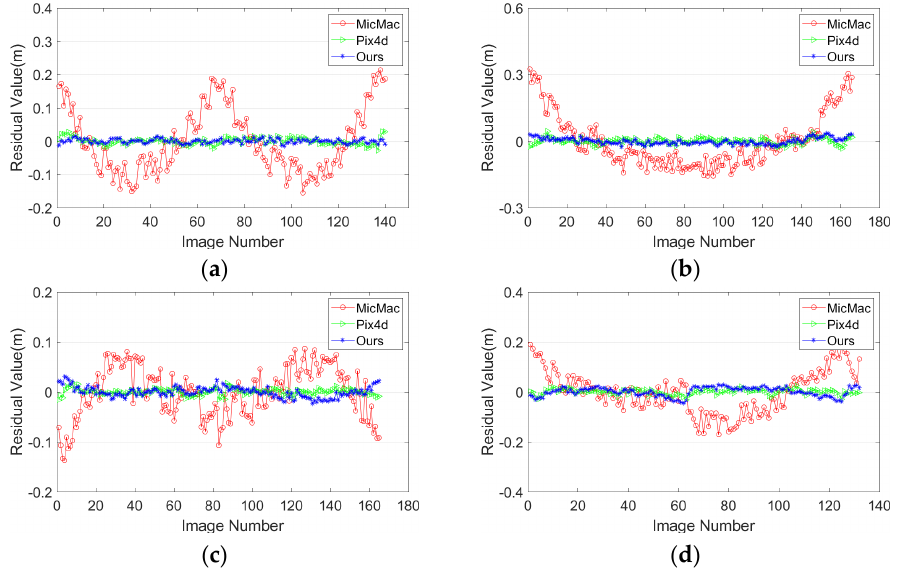
Figure 12. The coordinate offsets in the vertical direction between image projection center and differential GNSS location with different software. ( a , b ) The offsets in the vertical direction with the rectangle dataset and S-shaped dataset in test site 1; ( c , d ) the offsets in the vertical direction with the rectangle dataset and S-shaped dataset in test site 2.